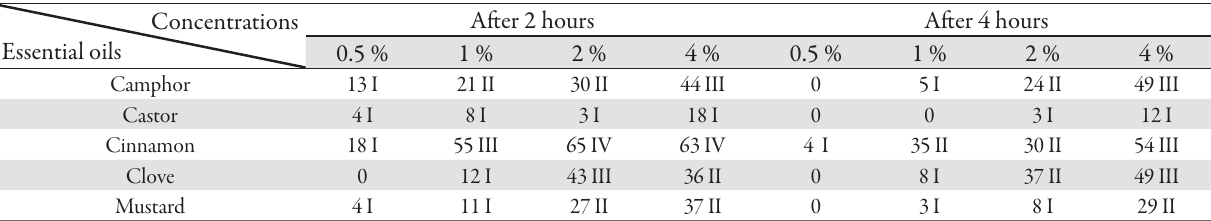
Tab. 1. Mean percent repellency (PR) values for five essential oils tested on adults of Bruchidius incarnatus ( Coleoptera: Bruchidae ) in free-choice